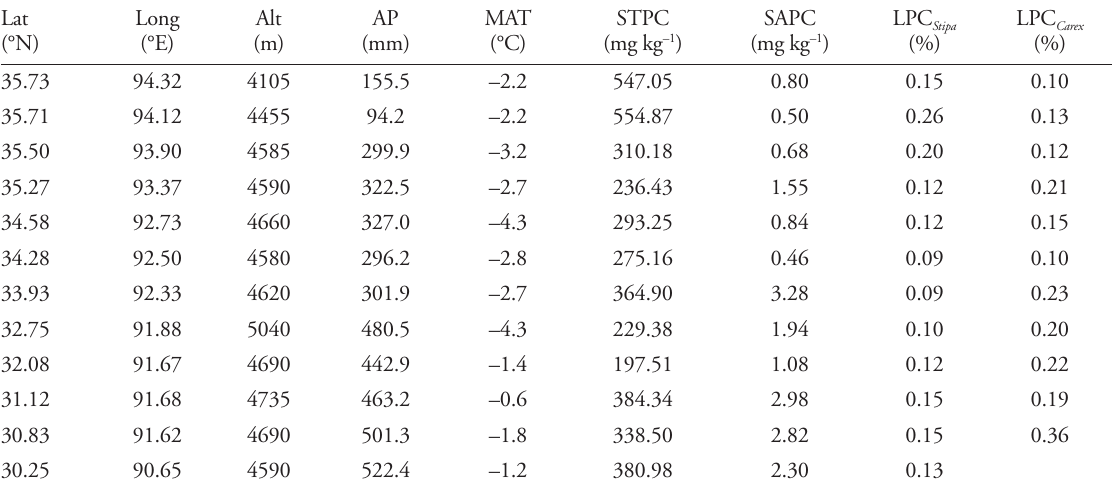
Table 2. Location (i.e. latitude (Lat), longitude (Long) and altitude (Alt)) of the sampling sites and their annual precipitation (AP), mean annual temperature (MAT), soil total phosphorus concentration (STPC), and soil available phosphorus concentration (SAPC), as well as leaf phosphorus concentration of Stipa purpurea (LPC ) and leaf phosphorus concentration of Carex moorcroftii (LPC- Stipa Carex